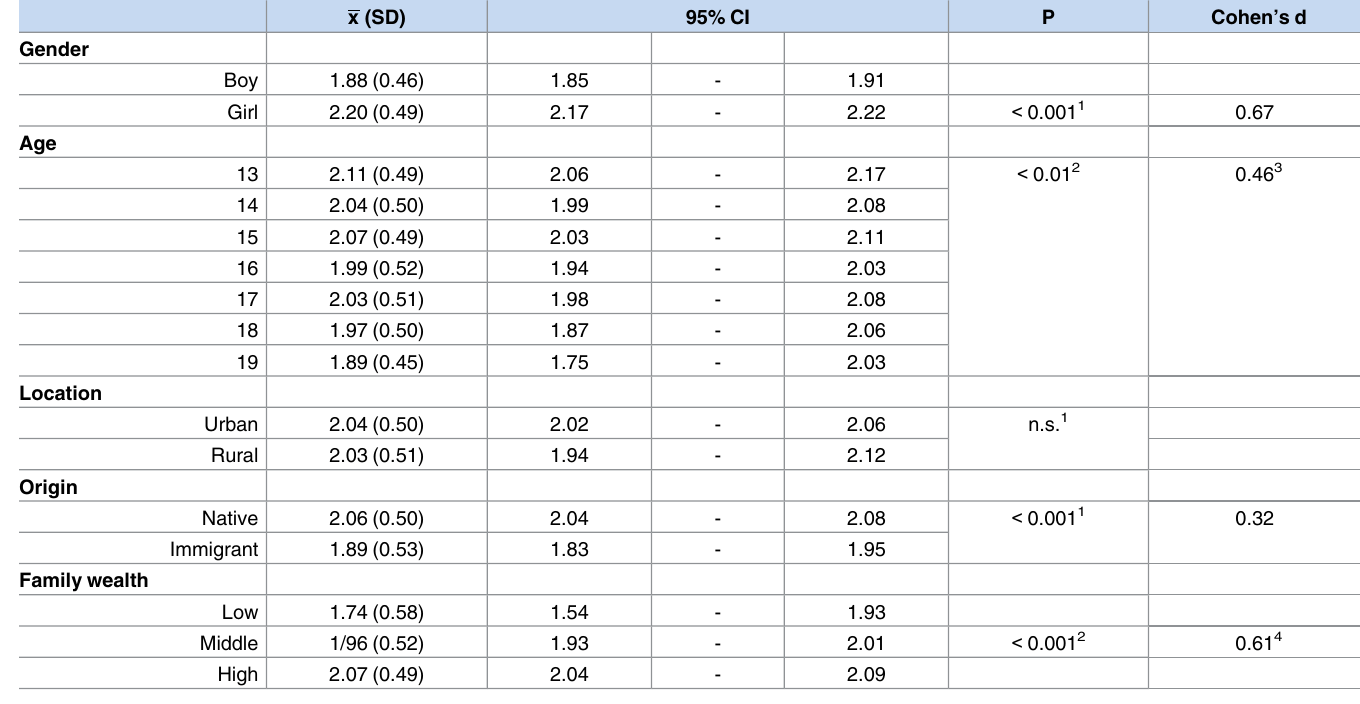
Table 4. Descriptiveanalysis of the diet component with respect to the different